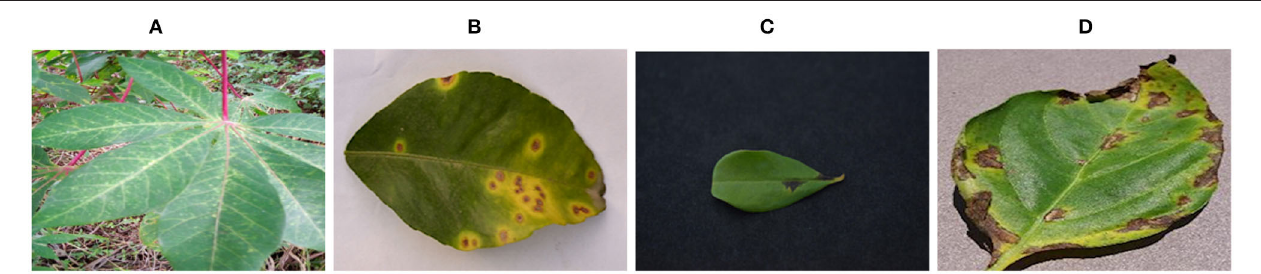
FIGURE 1 | Images from the plant disease classification datasets: Cassava (Mwebaze et al., 2019), Citrus leaves (Rauf et al., 2019), PlantLeaves (Chouhan et al., 2019), and PlantVillage (Hughes and Salathe, 2016). The images clearly illustrate the difference with the proposed task of stress detection on large canopies. (A) Cassava, (B) Citrus leaves, (C) PlantLeaves, and (D)